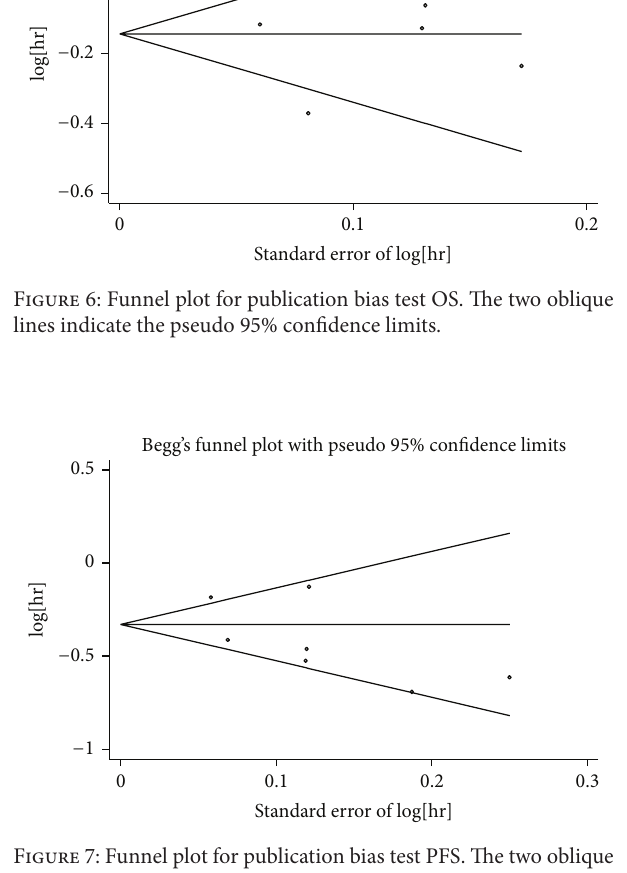
Begg’s funnel plot with pseudo 95% confidence limits 0.2